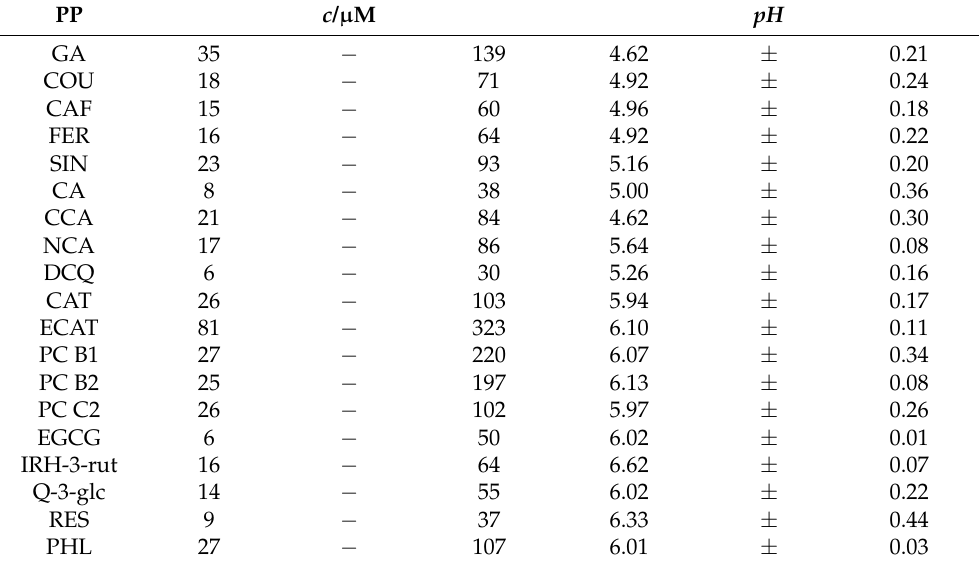
Table A1. pH values for aqueous solution of the phenolic compounds in the specified concentra- tion